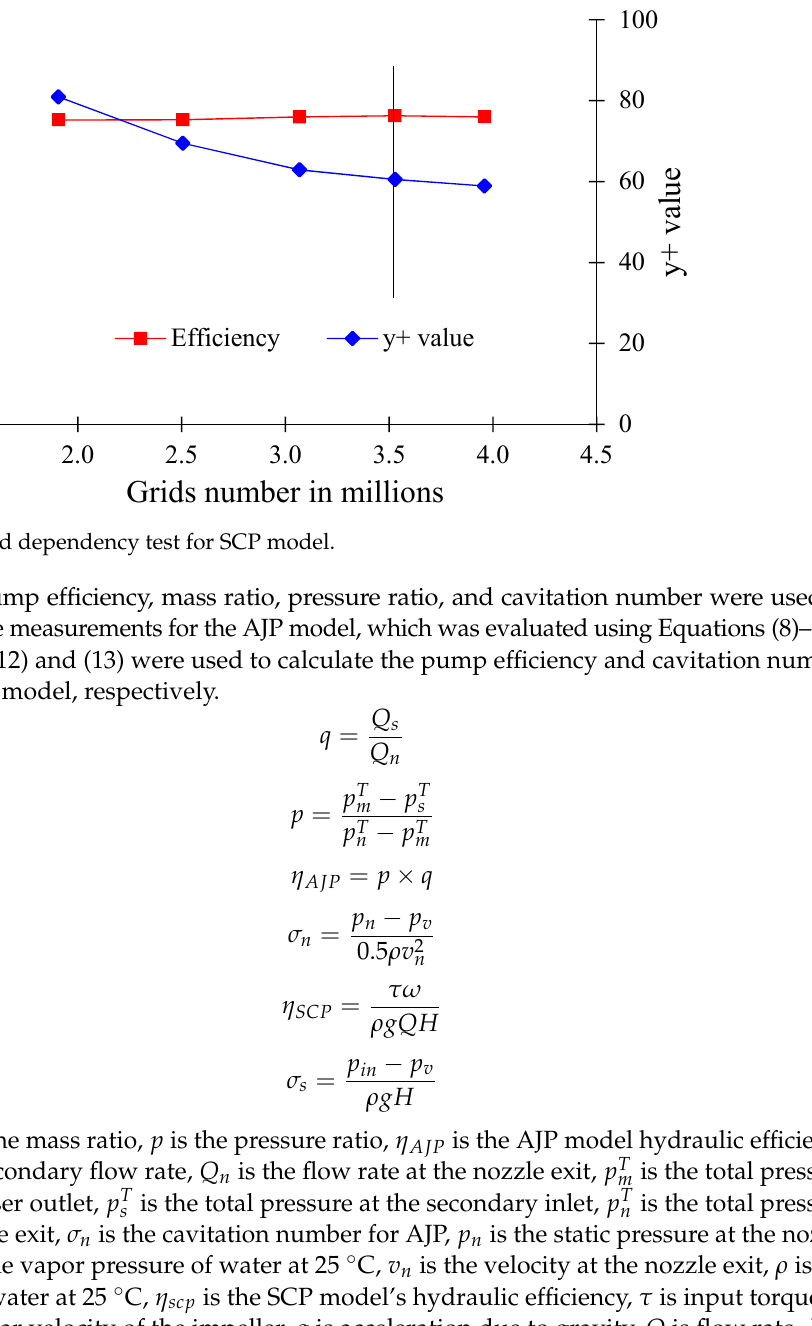
9 of 21 Figure 8. Grid dependency test for AJP model. Table 5. Grid dependency test for SCP CFD analysis via GCI method. 𝑵 𝟏 = 1.9 × 10 6 𝝓 𝟏 (Efficiency) 𝑵 𝟐 = 2.5 × 10 6 𝝓 𝟐 (Power) 𝑵 𝟑 = 3.6 × 10 6 𝝓 𝟑 (Head) 𝑟 (cid:2870)(cid:2869)